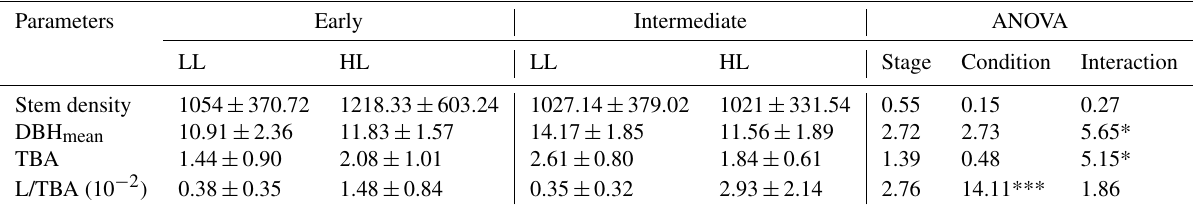
Table 1. Mean ( ± SD) of parameters of forest structure extracted from plots with different successional stages and different relative abundance of lianas in the dry forest at the Santa Rosa National Park in Costa Rica. Significant differences ( F values and their p values) according to the successional stages, relative abundance of lianas, and their interaction are represented by a posteriori ANOVA text extracted from a MANOVA. Stem density (stems/ha); DBH mean , mean stem diameter at breast height (cm); TBA, total basal area (m 2 ) ; L/TBA, ratio of liana basal area to TBA.